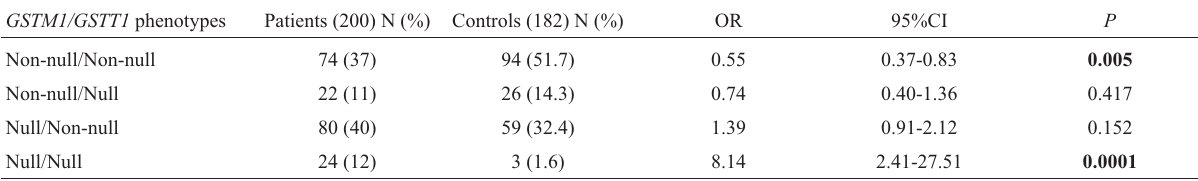
Table 3 - Odds ratio analysis of combined GSTM1/GSTT1 phenotypes in patients and controls. GSTM1/GSTT1